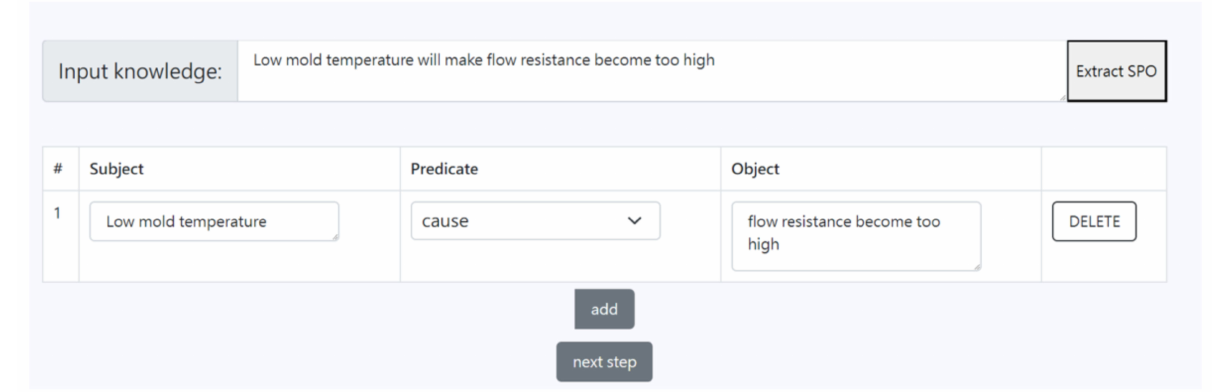
Figure 7. Real-time picture of knowledge extraction.